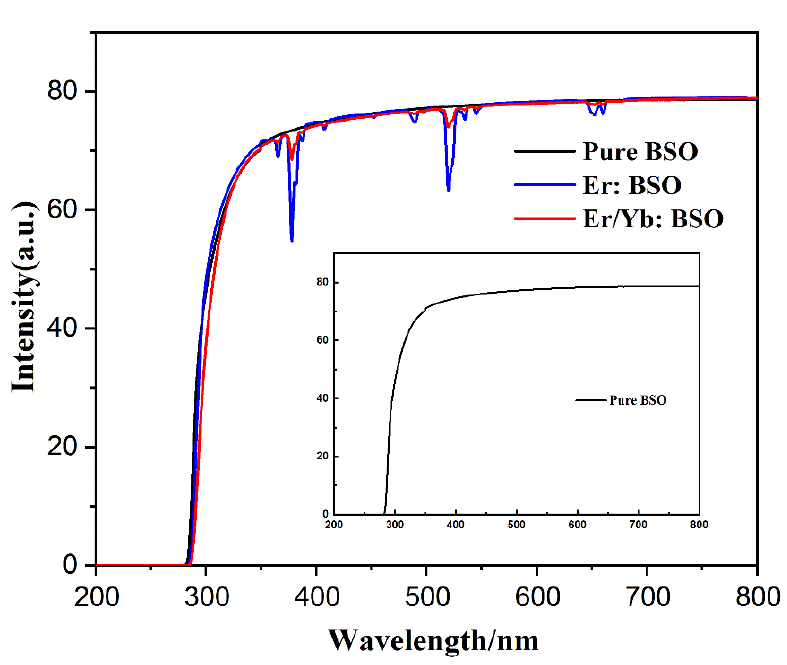
Figure 4. The transmission spectrum of pure BSO, Er: BSO, and Er/Yb: BSO crystals.